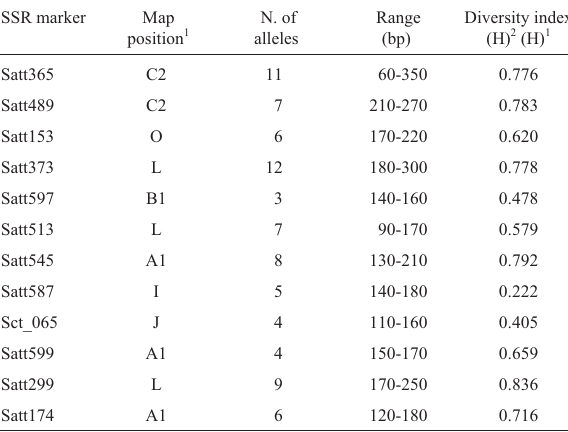
Table2 -The12simplesequencerepeat(SSR)markersusedinthisstudy. The number of alleles, size range, and diversity index were calculated us- ing all the cultivars from the three germplasm sources.